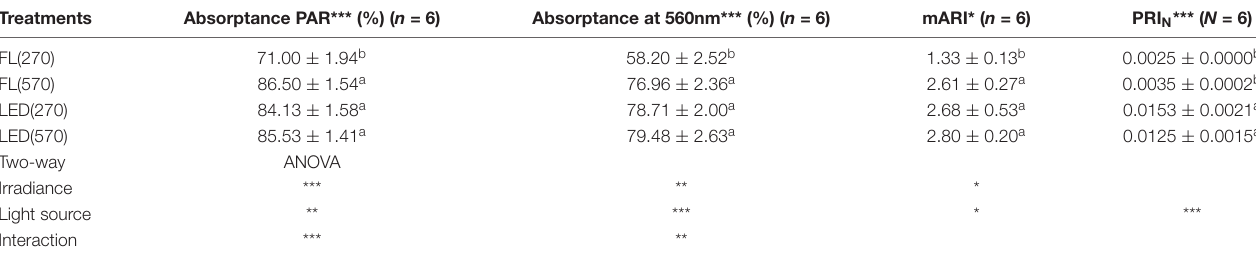
Values are reported as mean ± standard error of the mean. Different letters within columns indicate significant treatment differences at P < 0 . 05, as determined by Fisher’s least significant difference (LSD) test, with a > b > c. Significance codes (ANOVA): 0.000 “***,” 0.001 “**,” 0.01 “*.”